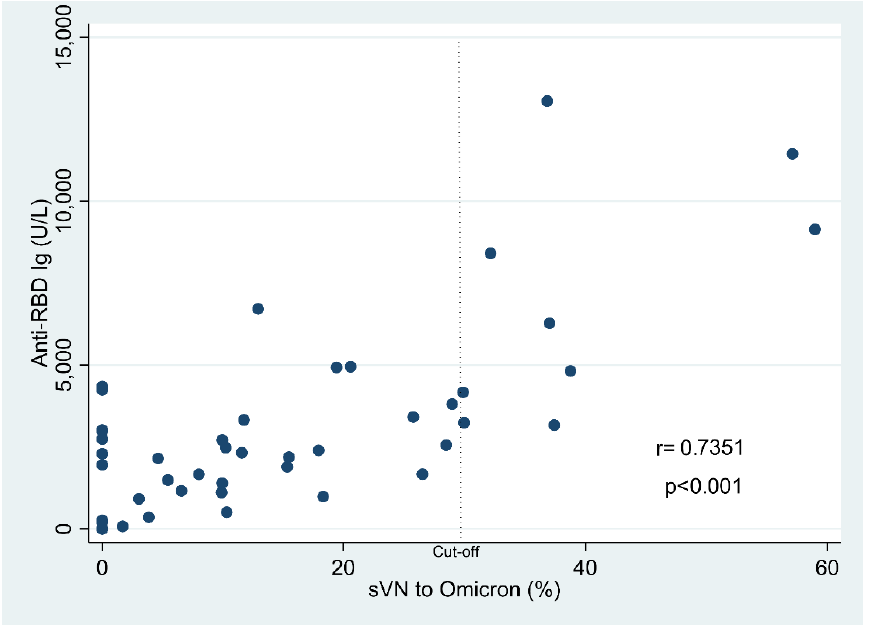
Figure 4. The Pea rson’s correlation between anti-RBD immunoglobulin and % inhibition of sVNT Figure 4. The Pearson’s correlation between anti-RBD immunoglobulin and % inhibition of sVNT to to Omicron variant. Omicron